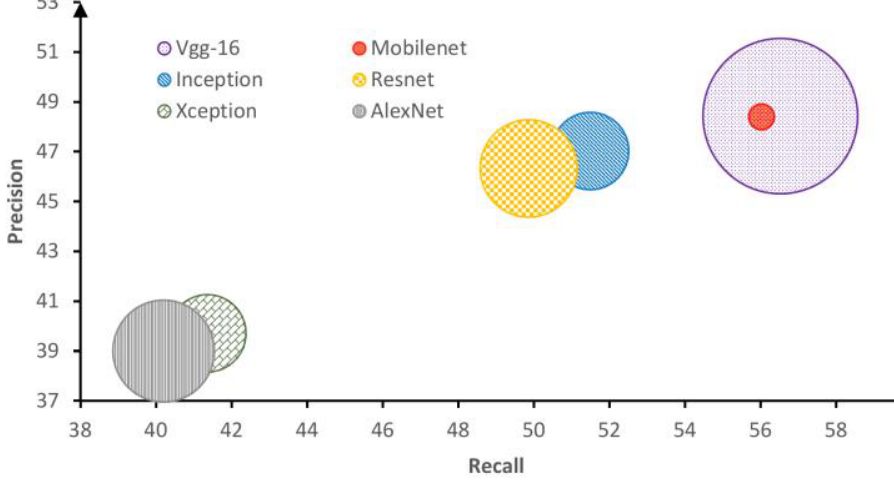
Figure 6. The impact of using different CNN models on our proposed method. The impact is measured in terms of precision, recall, and complexity.